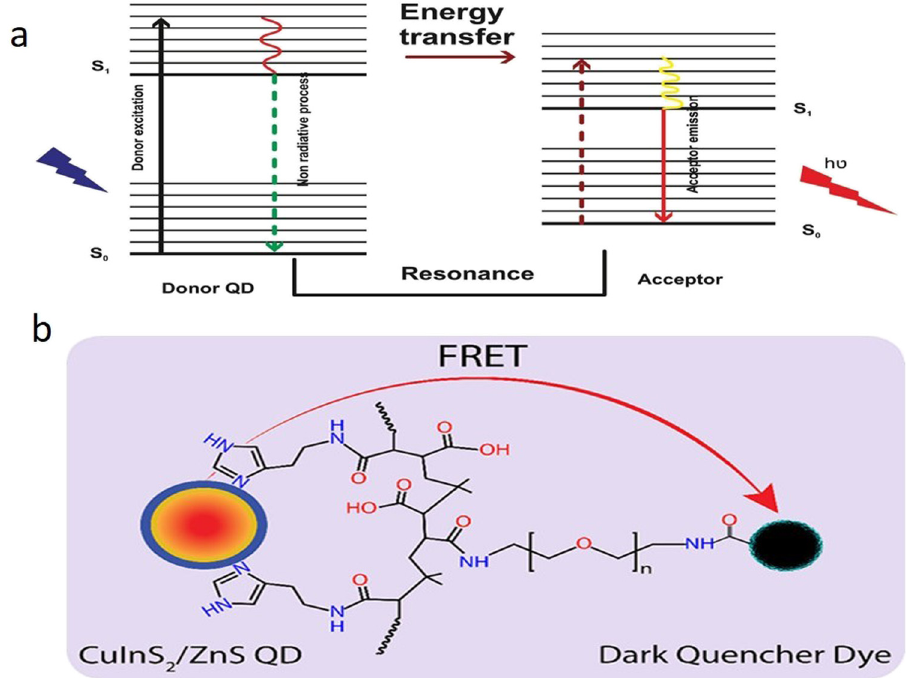
Figure 2: ( a ) Schematic diagram of energy transfer between a donor and an accepting chromophore; with permission from ref. [ 36 ] ; Elsevier. ( b ) Schematic illustration of FRET process between functionalized CIS/ZnS QDs and IR Dye QC - 1; with permission from ref. [ 45 ] ; ACS.